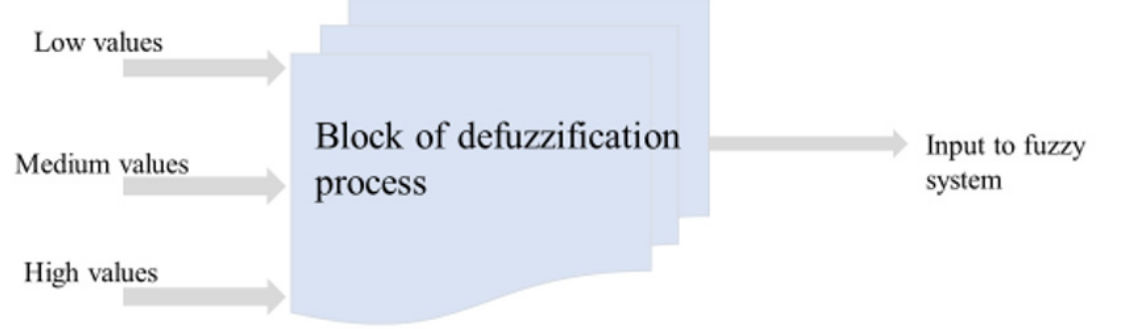
Figure 7. Defuzzification process.